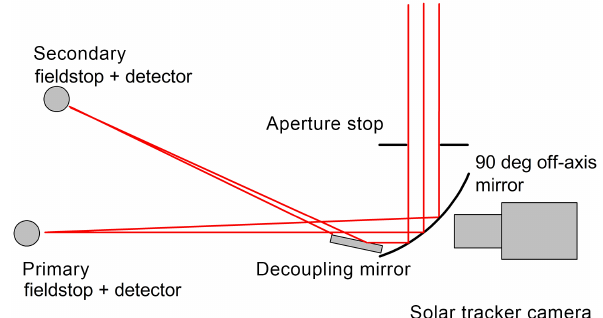
Figure 1. Schematic drawing of the detector branch of the extended EM27/SUN. The camera is located above the drawing plane and images the primary field stop. For clarity, the camera position has been shifted to the right in the drawing; it actually is located above the off-axis mirror.